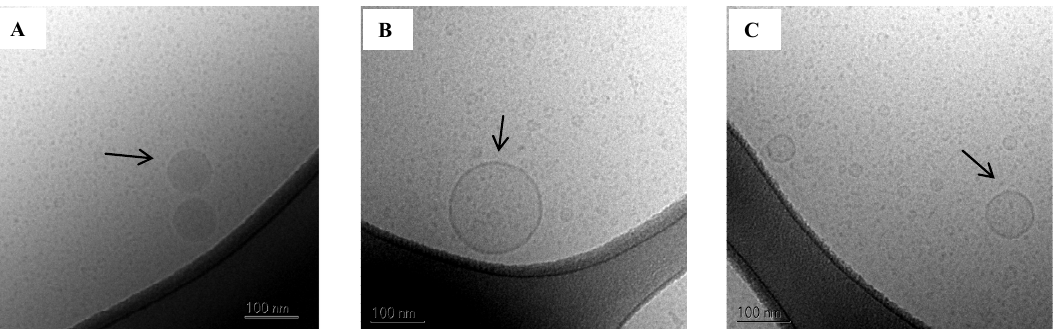
Figure 8. Cryo-TEM images of SNEDDS II 100% mimicked digested in SIM droplets; ( B ) and ( C ) Vesicles. The scale bar is 100 nm.